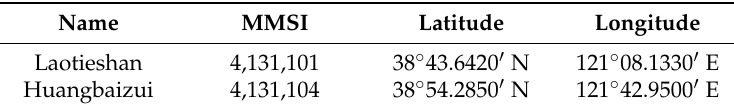
Figure 5. Simulation scenario. Table 1. Information on AIS base